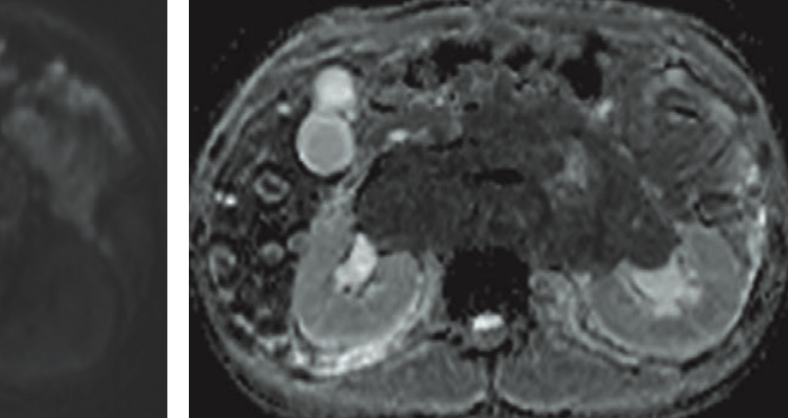
liver.Fig. 8. Axial CT scan image at the lung base level.